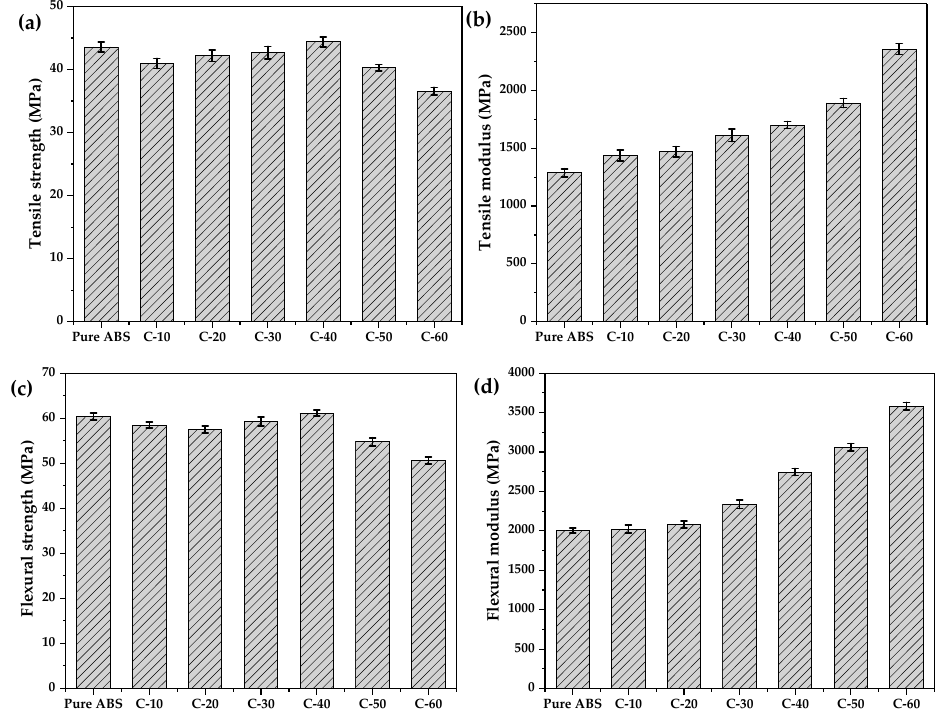
Figure 5. Mechanical properties of CIP/ABS composites with different CIP content. ( a ) Tensile strength. ( b ) Tensile modulus. ( c ) Flexural strength. ( d ) Flexural modulus. Sample C-40 with a CIP content of 40 wt.% presented similar tensile and flexural strengths